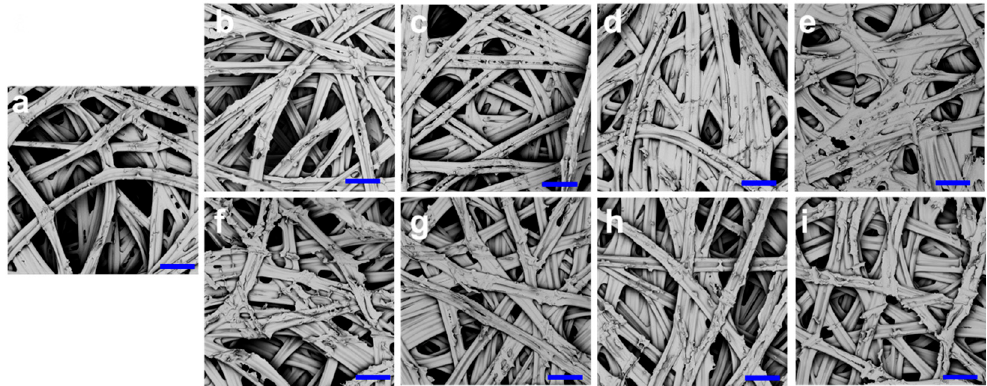
Figure 2. SEM images of cocoon layer structure. ( a ) Normal cocoon; ( b ) PT-25 cocoon; ( c ) PT-20 cocoon; ( d ) PT-14 cocoon; ( e ) PT-12 cocoon; ( f ) CB-20 cocoon; ( g ) CB-17.5 cocoon; ( h ) CB-15 cocoon; ( i ) CB-12.5 cocoon. Scale bar: 100 μ m.